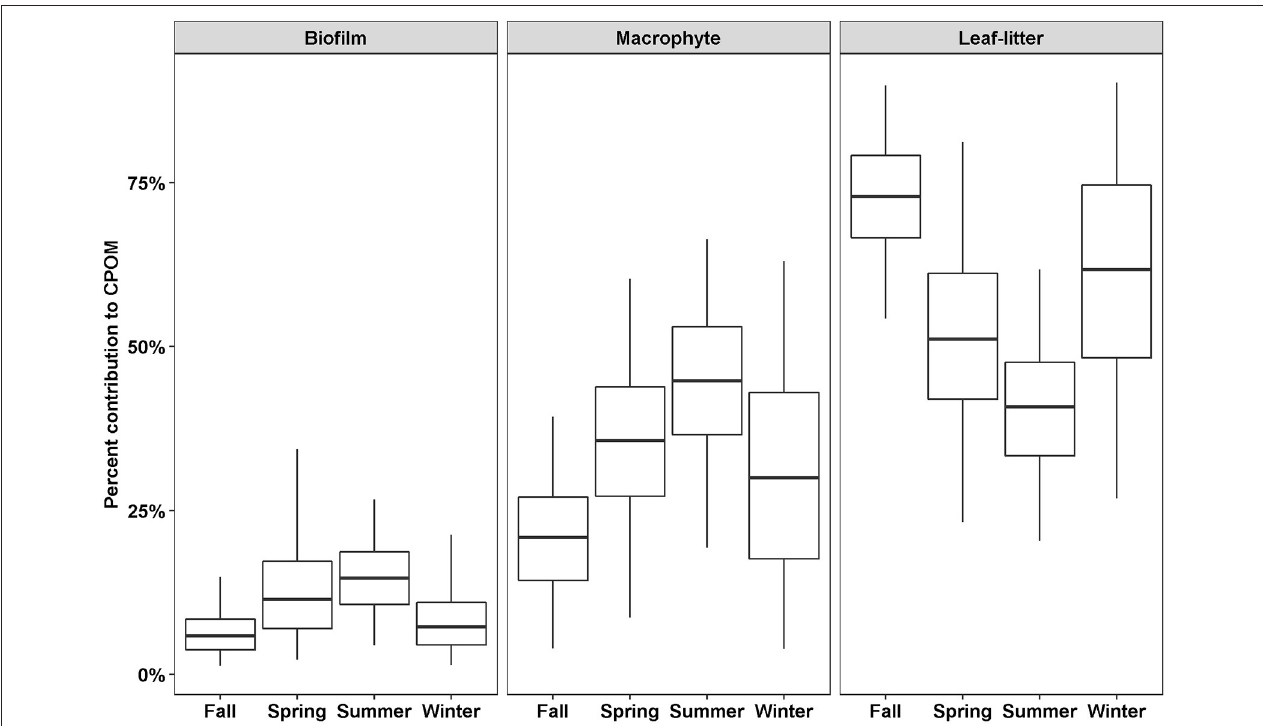
FIGURE 3 | The percent feasible contributions to CPOM for three sources depending on season. Contributions were estimated using SIMMR with three isotope tracers, δ 13 C, δ 15 N, and δ 2 H. Boxes represent the median and interquartile range; whiskers represent 2.5 and 97.5 percentiles.